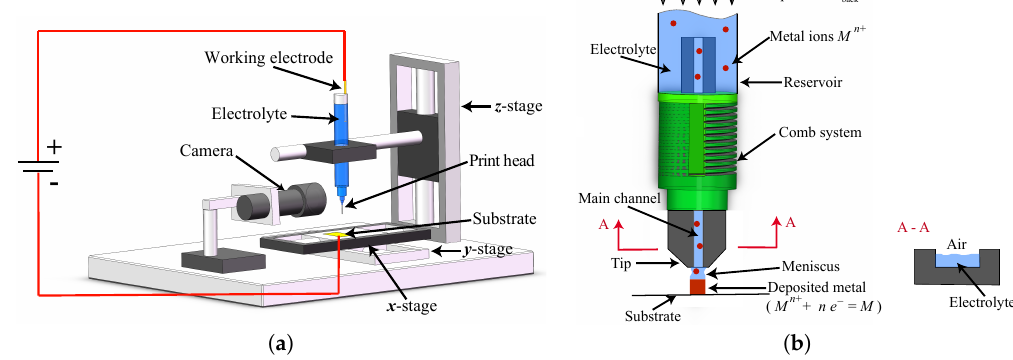
Figure 1. ( a ) Schematic illustration of the proposed ECAM system. ( b ) Detailed illustration of the print head, also referred to as the fountain pen feed system. The cross section A–A at the tip of the main channel is shown in the lower right